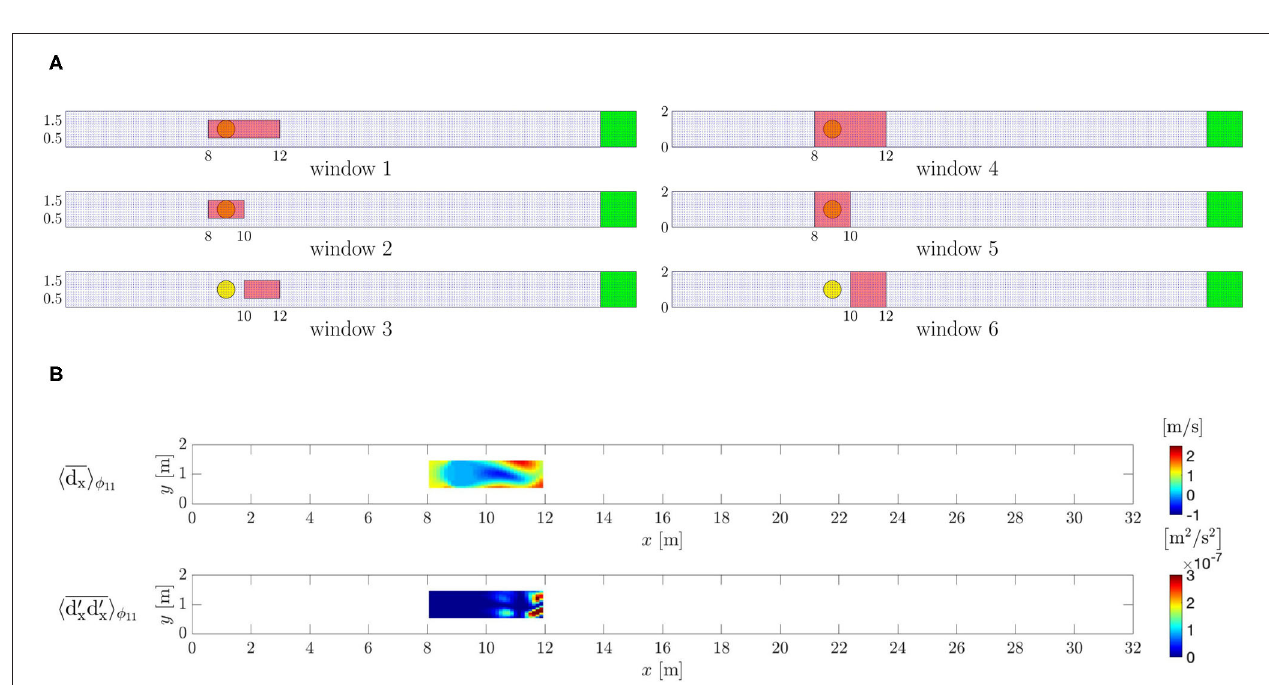
FIGURE 3 | Periodically oscillating flow: vorticity ω fields for two different phase averaging. φ 1 corresponds to basic time t 1 = 0.099755 [s], while φ 11 corresponds to basic time t